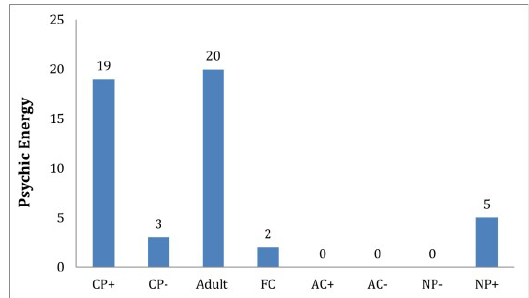
Chart 10: Egogram Teacher 7 with Student 1 Chart 10 shows the egogram of Teacher 7 with student 7-1. The highest proportion of psychic energy in this egogram is related to Adult. This chart had the second lowest proportion of FC compared to all the other